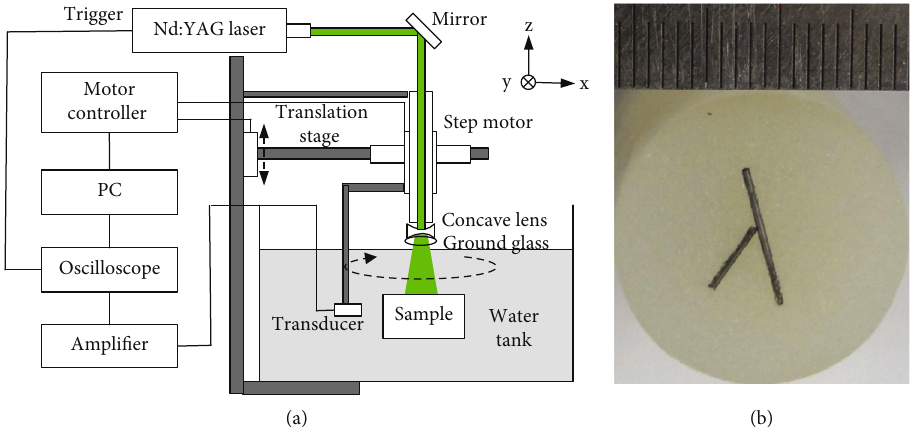
Figure 7: (a) The schematic of PAI system. (b) Cross-sectional view of a cylinder agar phantom containing two carbon rod